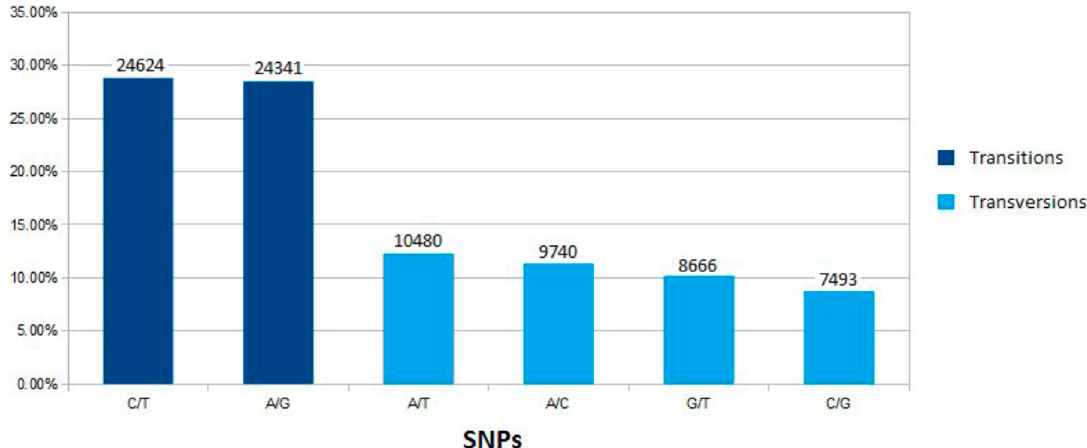
Figure 1. Single nucleotide polymorphisms (SNPs) detected in muscle and liver turbot RNA-seq. SNPs found by RNA-seq and aligned with turbot genomic sequences are separated according to their type.